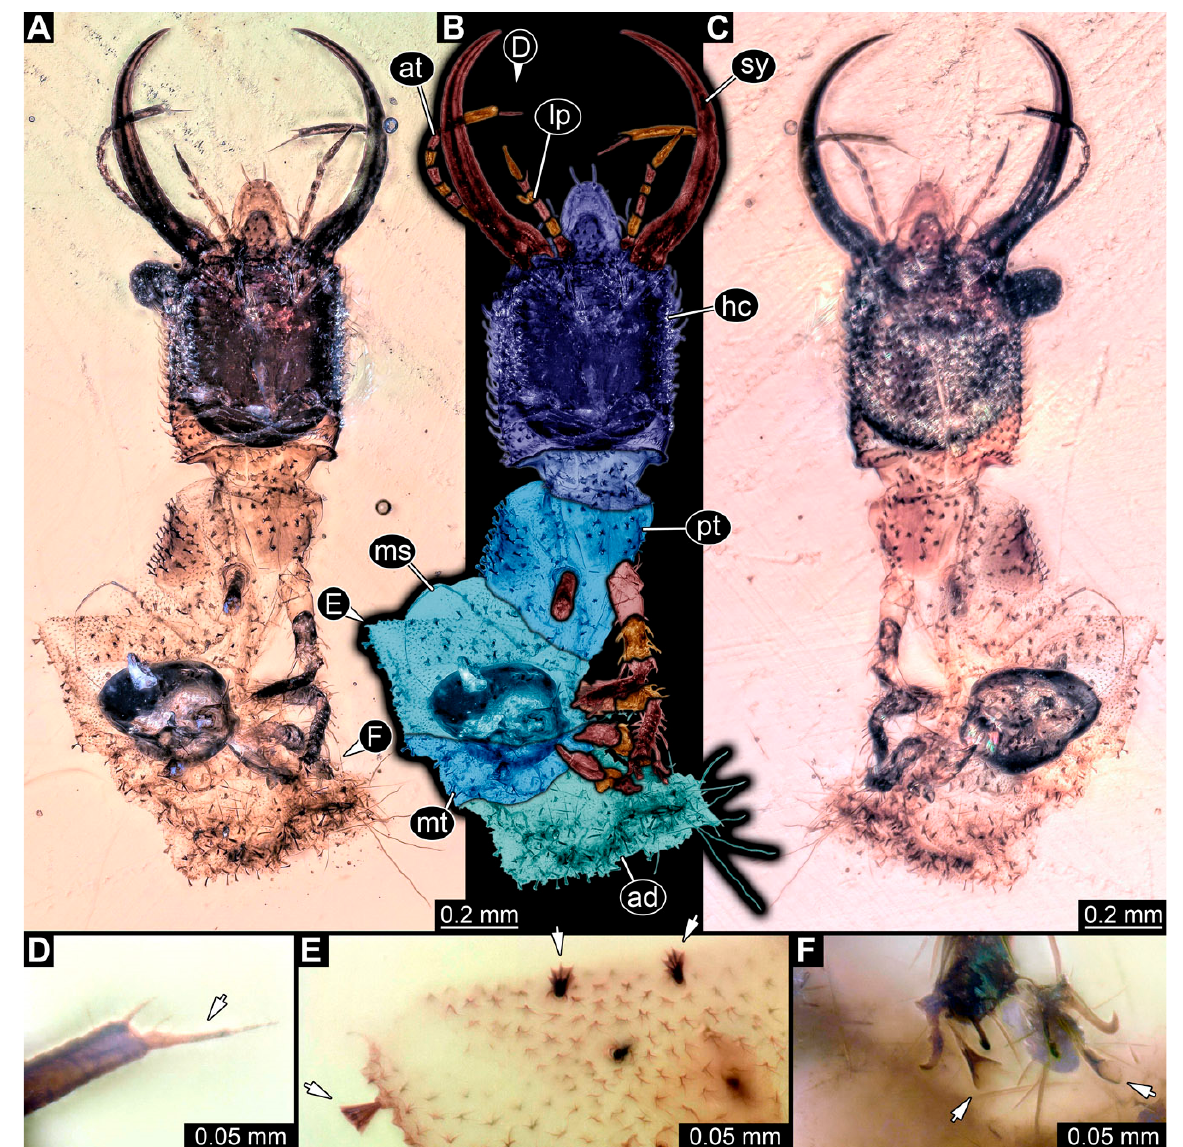
Figure 16. Specimen 77 (PED 1666); Myanmar amber. ( A ) Dorsal view. ( B ) Dorsal view, colour- marked. ( C ) Ventral view. ( D ) Close-up of antenna with distal seta; arrow marks seta. ( E ) Close-up of dolichasterine setae; arrows mark setae. ( F ) Close-up of second and third locomotory appendages; arrows mark empodia. Abbreviations: ad = abdomen; at = antenna; hc = head capsule; lp = labial palp; ms = mesothorax; mt = metathorax; pt = prothorax; sy = stylet. (26) Specimen 78 (PED 1703) is preserved in Cretaceous Myanmar amber (Figure 17). The dorsal (Figure 17C) and ventral (Figure 17A,B) sides are accessible, but are strongly concealed by dirt and Verlumung. Half of one stylet is missing distally. The labrum ap- pears pentagonal, but well rounded in the dorsal view (Figure 17D). Trumpet-shaped em- podia at the end of the locomotory appendages are visible (Figure 17E). The specimen has an approximate length of 2.9 mm.